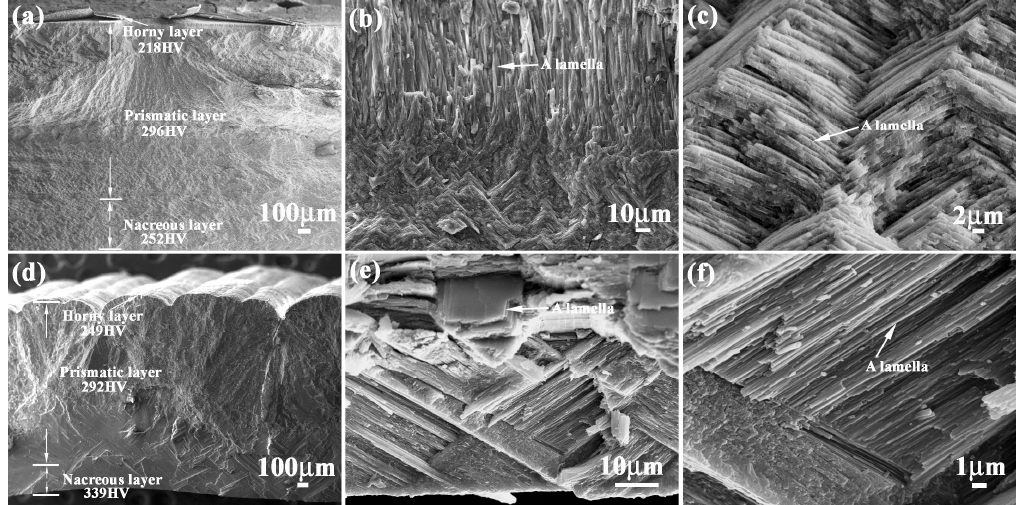
Figure 1. Microstructure of ( a – c ) Meretrix lusoria shell and ( d – f ) Rapana venosa shell. ( a ) layered morphology of Meretrix lusoria shell; ( b ) microstructure of the conterminous area between prismatic layer and nacreous layer; ( c ) magnified morphology of nacreous layer; ( d ) layered morphology of Rapana venosa shell; ( e ) microstructure of the conterminous area between prismatic layer and nacreous layer; ( f ) magnified morphology of nacreous layer.